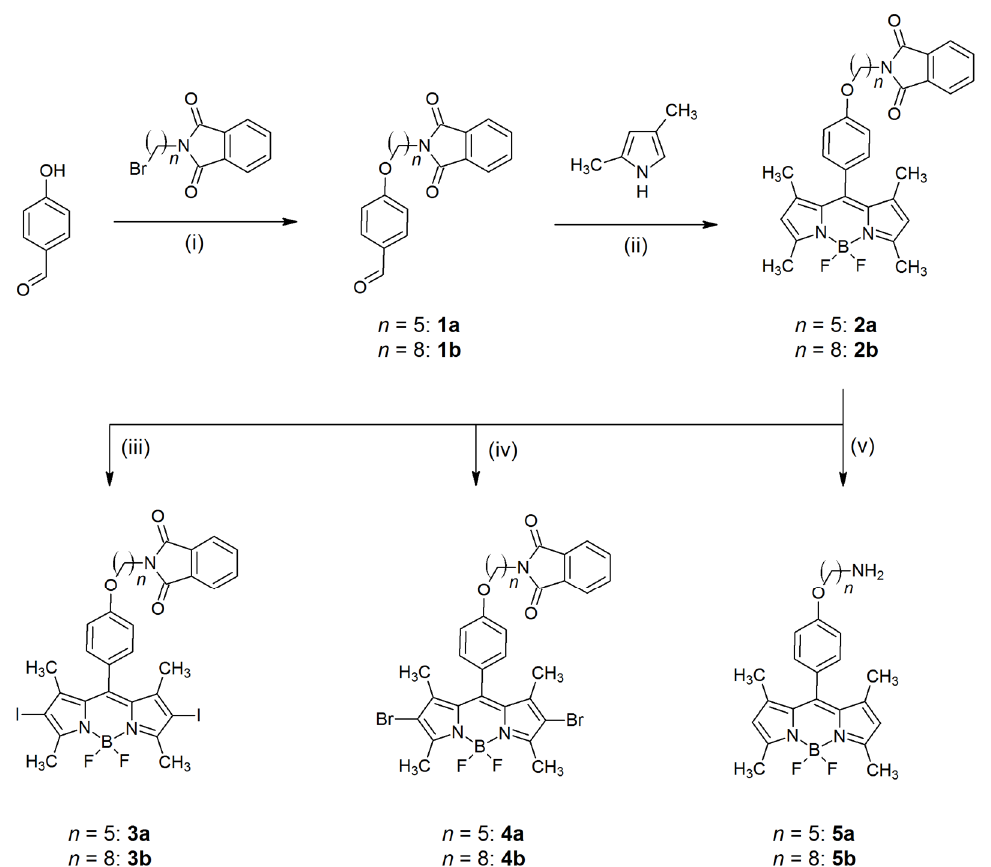
Scheme 1. Synthesis of BODIPYs 2–5 . Reagents and conditions: (i) K 2 CO 3 , DMF, 70 °C; (ii) 1. CF 3 COOH, CH 2 Cl 2 , 1 h; 2. DDQ, CH 2 Cl 2 , 1 h; 3. DIPEA, BF 3 • Et 2 O, r.t., 6 h; (iii) I 2 , HIO 3 , C 2 H 5 OH, 70 ◦ C, 30 min or NIS, CH 2 Cl 2 , r.t., 3 h ( 3b ),